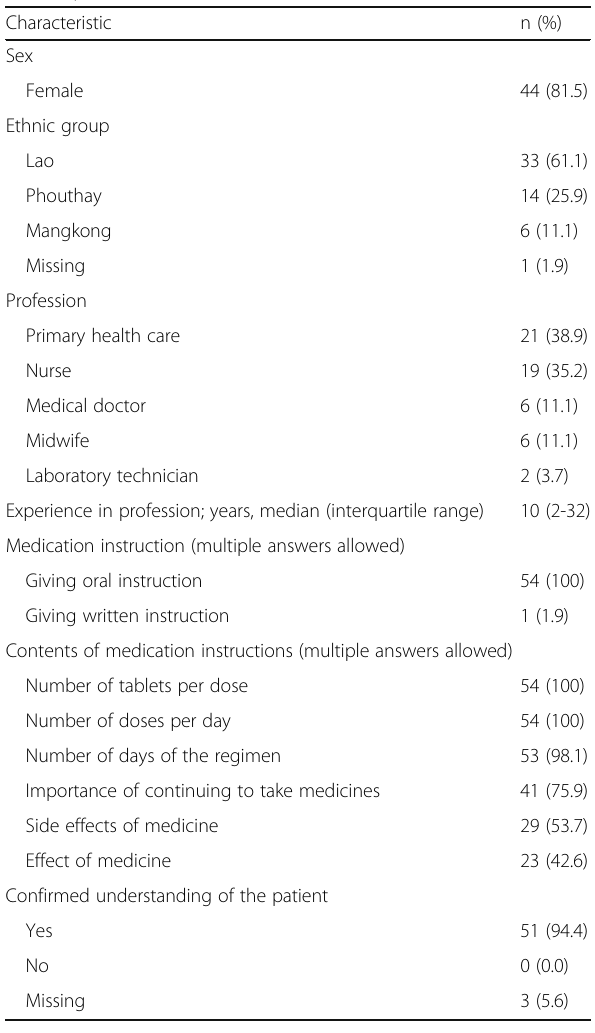
Table 3 Socio-demographic, characteristics of the healthcare workers in the patient study and their medication instructions for the patients